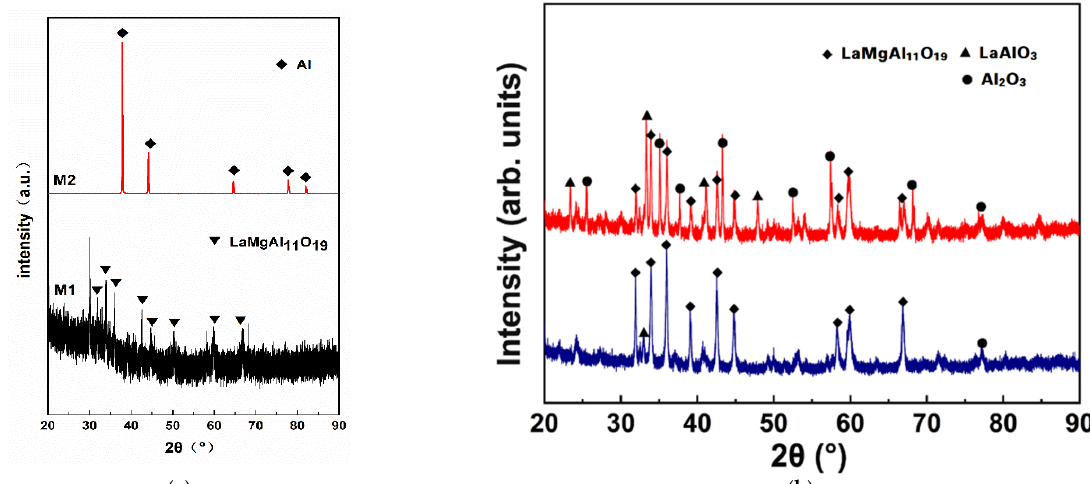
Figure 13. XRD results of Al layer ( a ) before and ( b ) after oxidation test at 1200 °C.